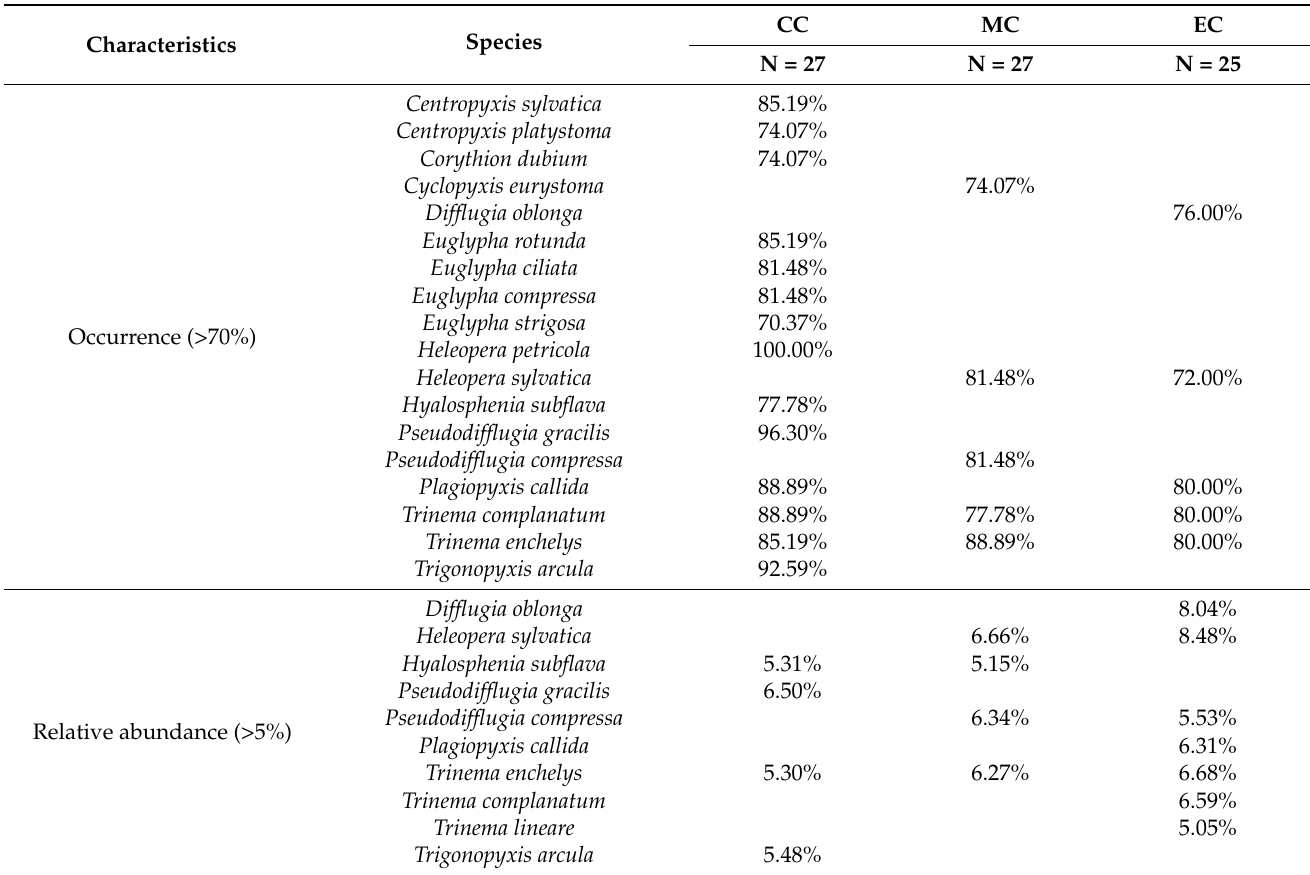
Table 1. The most abundant and the most common species under the three tree crown positions. (Relative abundance: the number of individuals of a species as a proportion of the total number of individuals of all species per gram of soil. Occurrence: the number of occurrences of a species in the samples as a proportion to the total number of